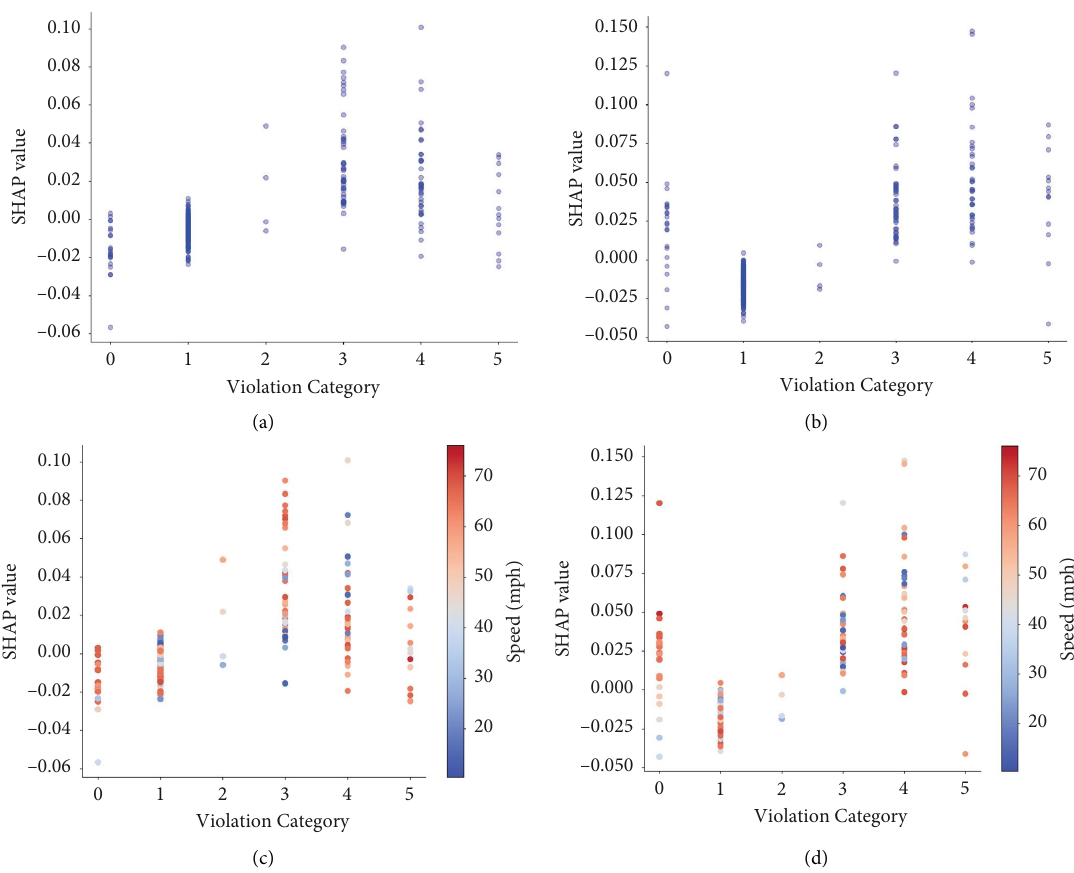
Figure 8: SHAP local dependence plots of violation category. (a) Main efects of the violation category on the time gap. (b) Main efects of violation category on the distance gap. (c) Interaction efects between violation category and speed on the time gap. (d) Interaction efects between violation category and speed on the distance